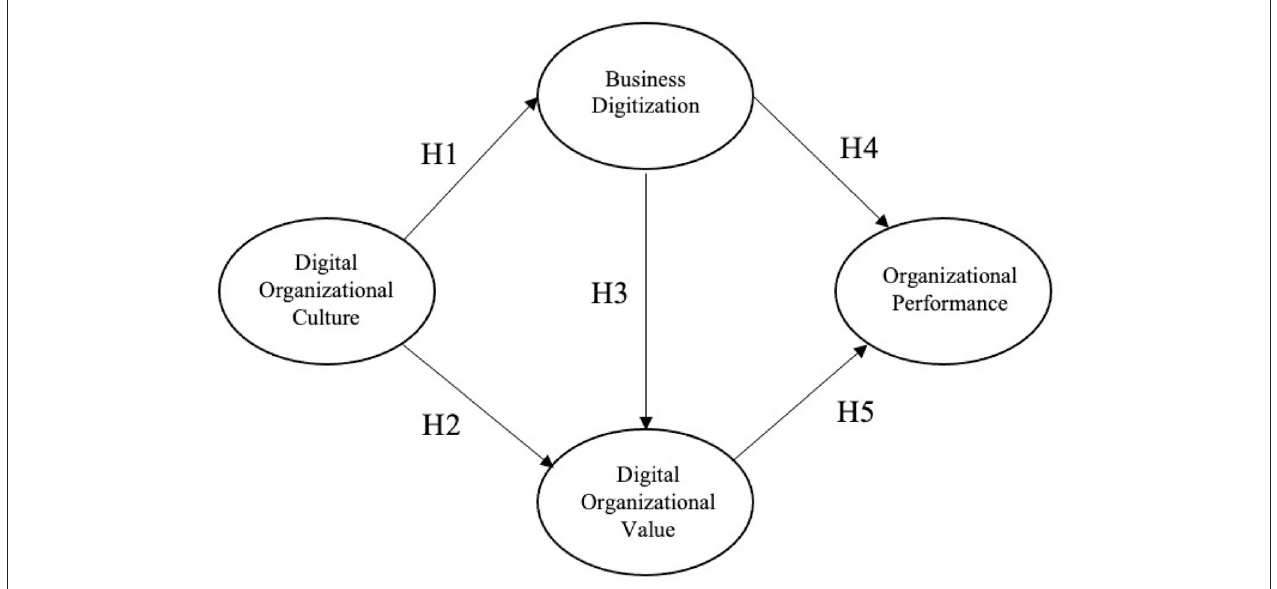
FIGURE 1 | Research model (adopted from Martínez-Caro et al.,